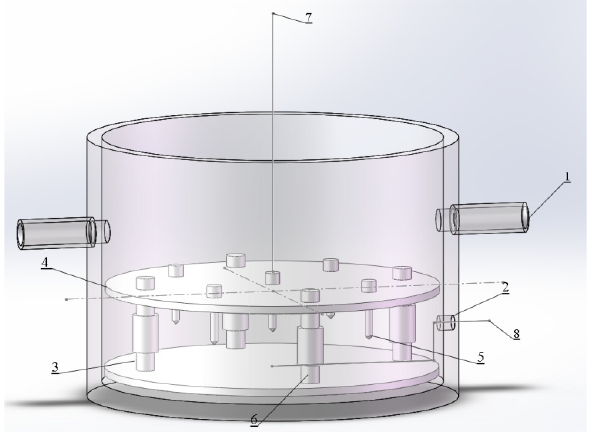
Figure 1. The sketch map of a novel plasma reactor. (1. Air vent 2. Sample collection hole 3. Grounded electrode plate 4. Discharge electrode plate 5. Discharge needle 6. Nylon column 7. Power lead 8. Ground lead).